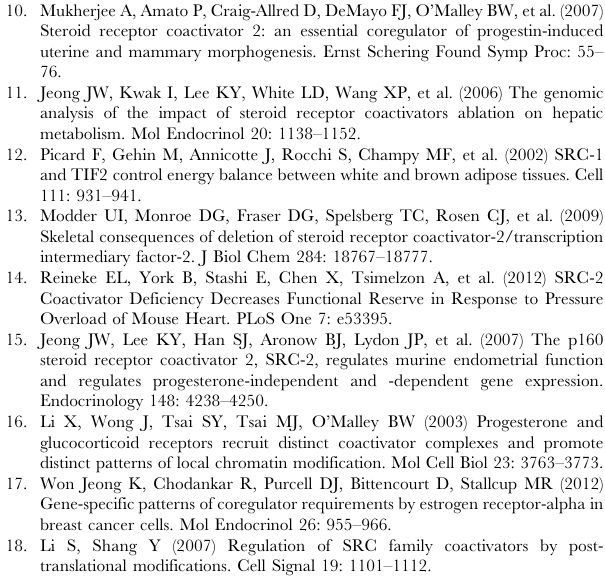
Figure S1 Correspondence analysis (CA) plot showing projection of microarray samples. Ctr shRNA: pink squares, SRC-2 shRNA: green diamonds, cAMP: purple circles. The first principle component is shown on the x-axis and the second principle component is displayed on the y-axis. All three groups of samples are separated along the first principle component (22.706% component variance). The second principle component (15.192% component variance) separates the two groups of treated samples (SRC-2 shRNA and cAMP) from the control group sample (Ctr shRNA).